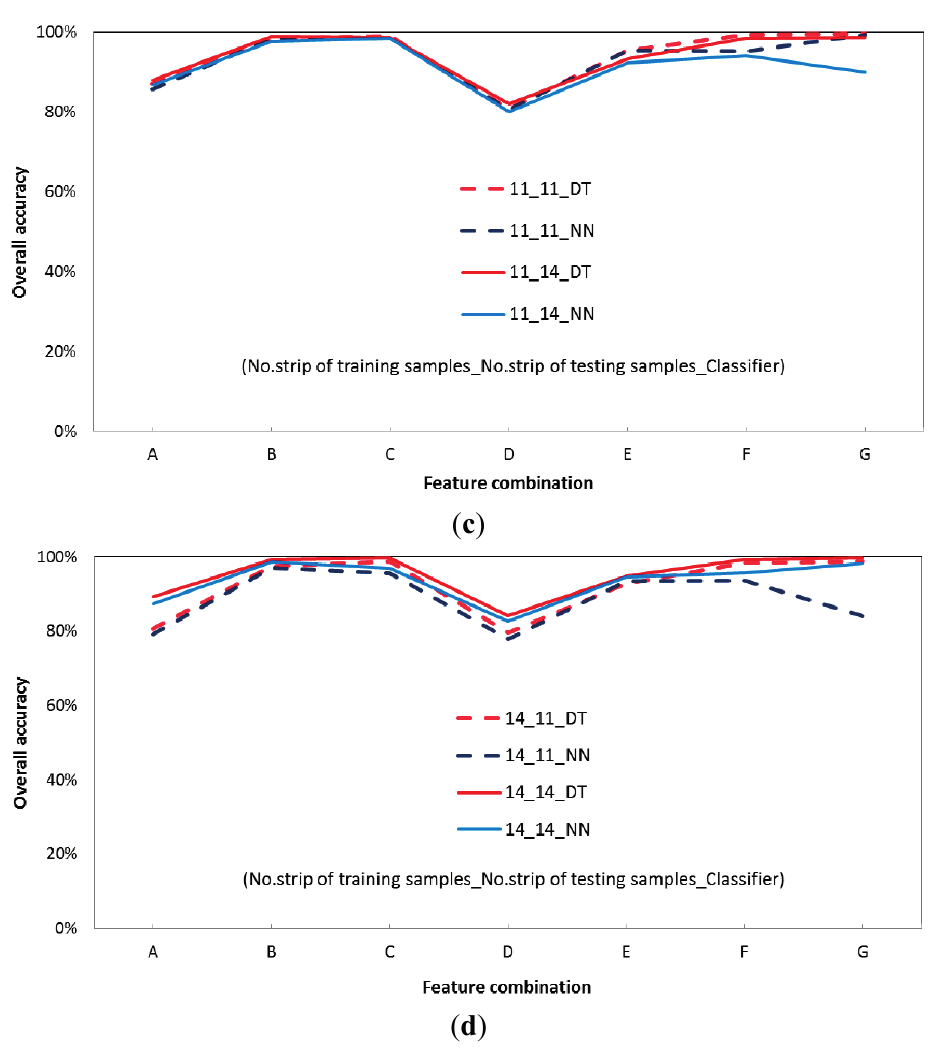
Figure 9. Overall accuracy of feature combinations from data from the same flight missions using the decision tree (DT) and neural network (NN) algorithms: ( a ) training samples (01), testing samples (01 or 02); ( b ) training samples (02), testing samples (01 or 02); ( c ) training samples (11), testing samples (11 or 14); ( d ) training samples (14), testing samples (11 or 14). Labels on the x -axes are as follows. A:{ Linearized Amplitude , and Width }, B:{ Linearized Amplitude , Width , and dZ }, C:{ Linearized Amplitude , Width , RSS h , and dZ }, D:{ γ and FW cv }, E:{ γ , FW cv , and dZ }, F:{ γ , FW cv , RSS h , and dZ }, and G:{ Linearized Amplitude , Width, γ , FW cv , RSS h , and dZ